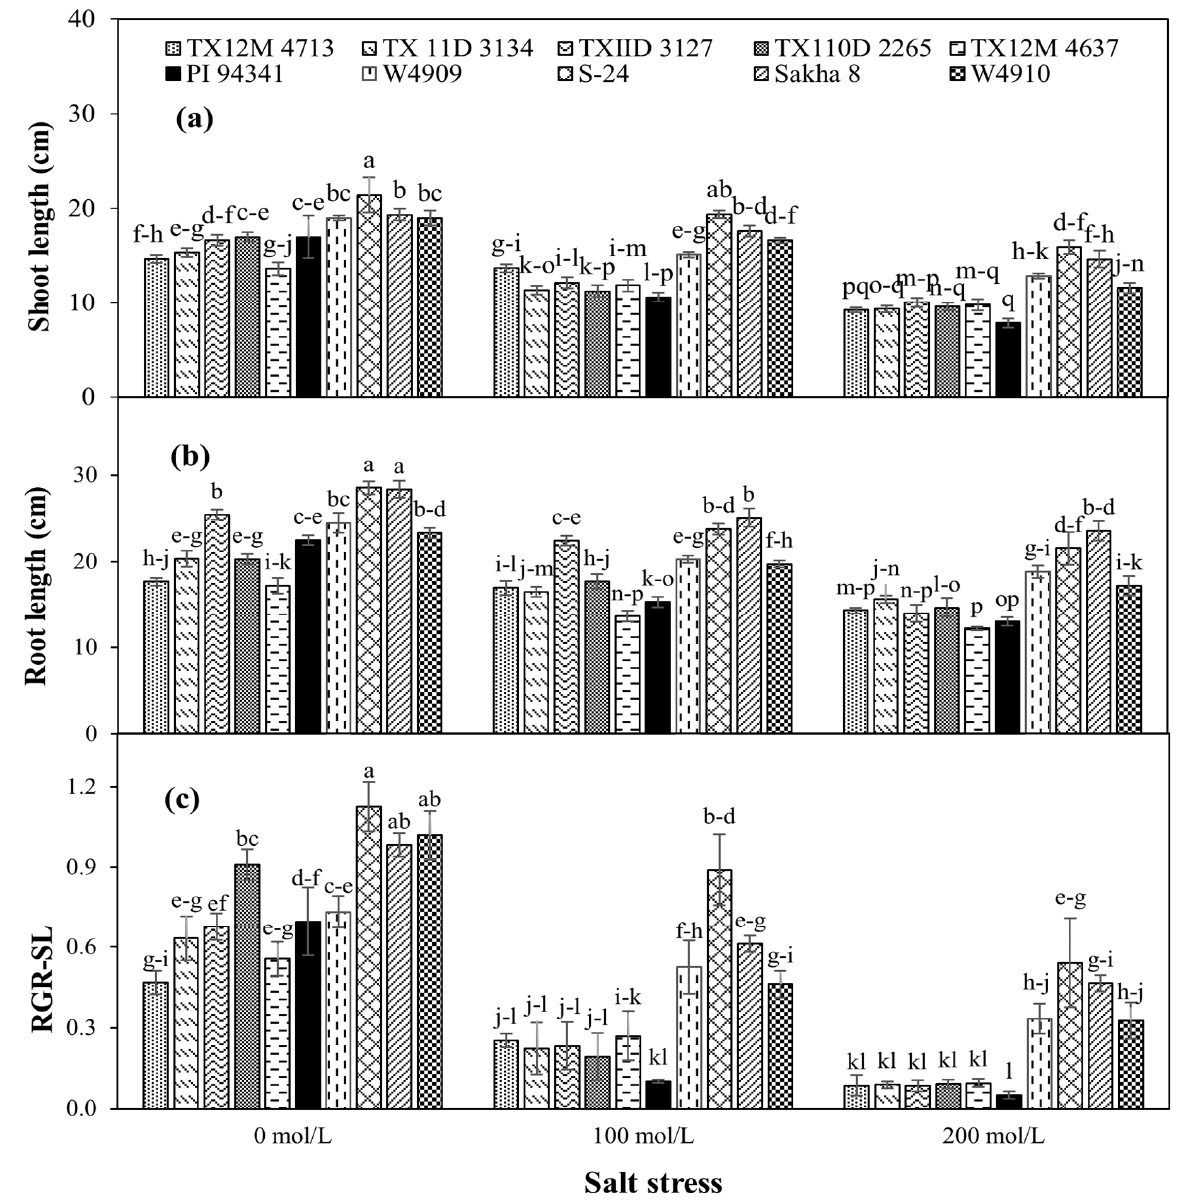
Figure 3. Influence of salt stress on ( a ) shoot length, ( b ) root length, and ( c ) relative growth rate of shoot length (RGR-SL) on wheat genotypes. Error bars indicate S.E. ( n = 3 ). Different letters above the bars represent significant differences at the p < 0.05.